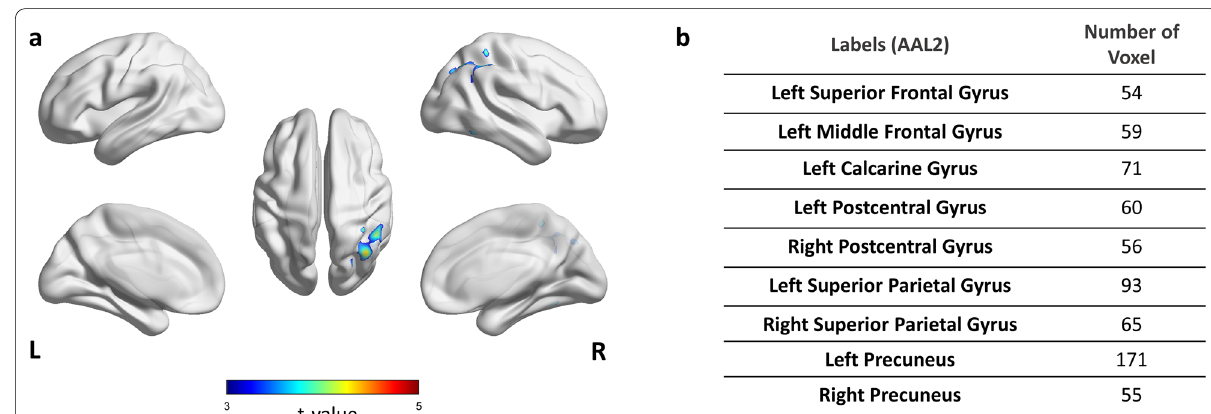
Automated Anatomical Labeling; =